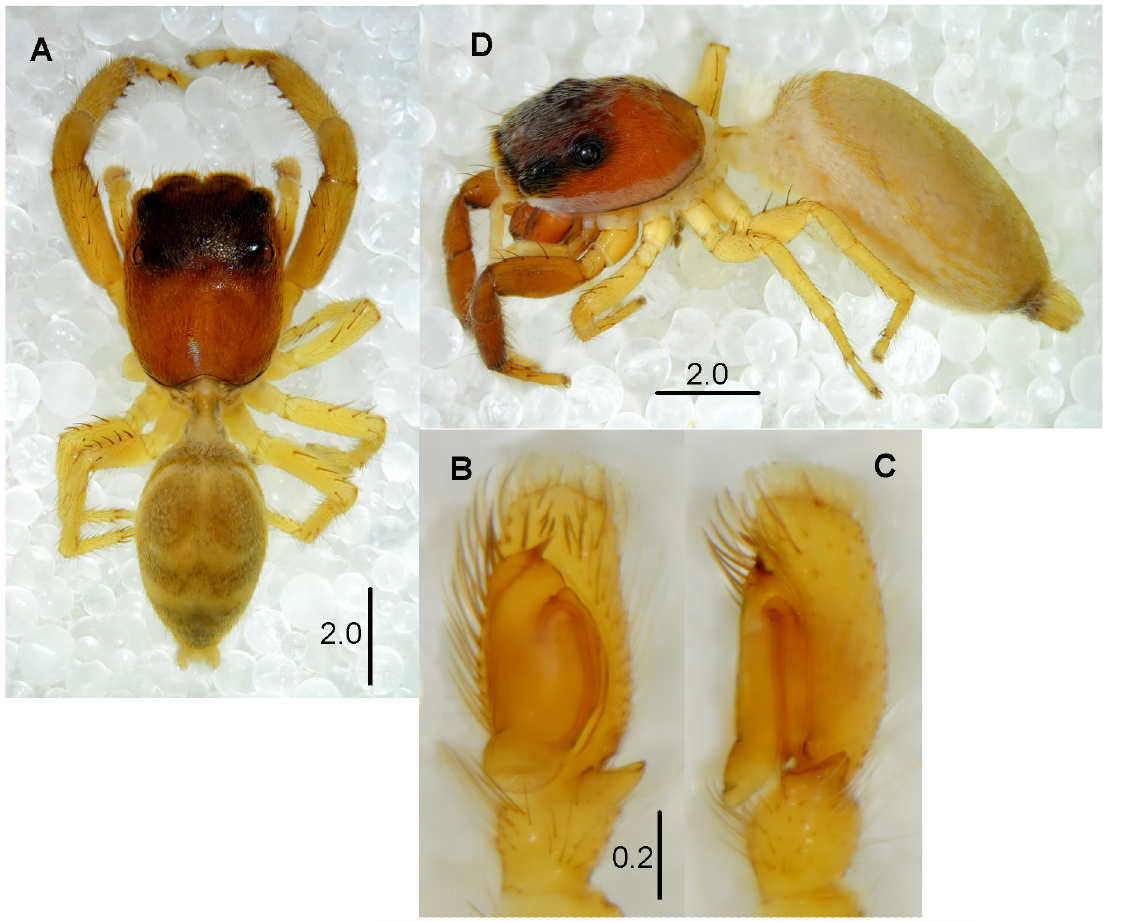
Fig. 27. Icius bandama sp. nov. A–C . Holotype, ♂ (MNHN). D . Paratype, ♀ (MNHN). A . Habitus of male, dorsal view. B . Palpal organ, ventral view. C . Palpal organ, lateral view. D . Habitus of female, lateral